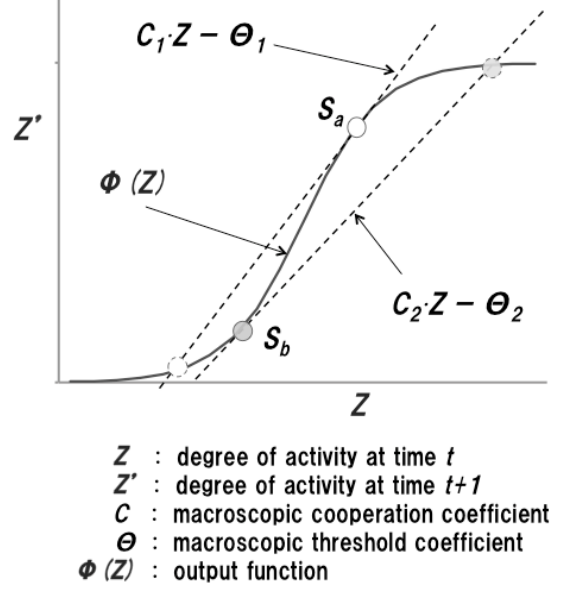
Figure 2. Image of unstable state of activity